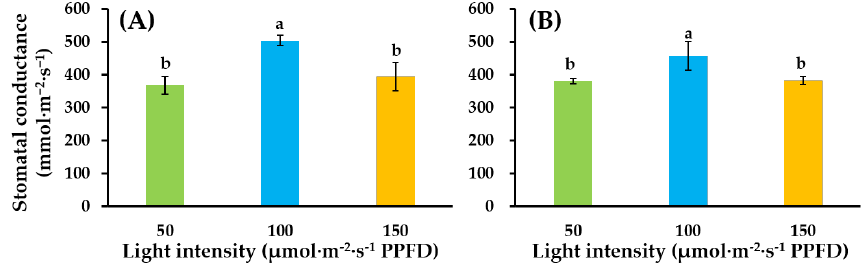
Figure 3. Influence of supplementary lighting intensity on stomatal conductance of two cultivars of tomato ‘SS’ ( A ) and ‘SD’ ( B ) grafted onto the ‘B-Blocking’ rootstock. The error bars represent SEs of three biological replicates ( n = 3). According to the Duncan test, lowercase letters at p ≤ 0.05 indicate significant differences between treatments.